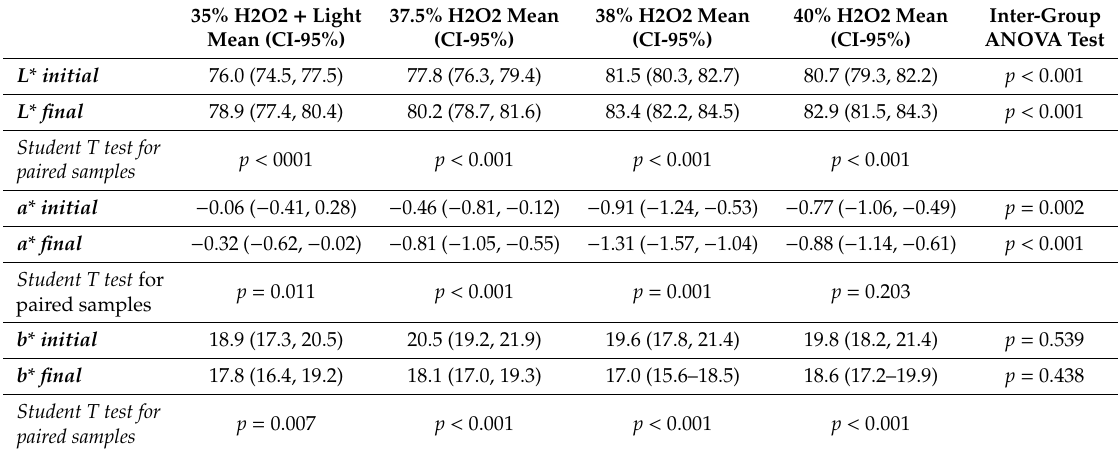
Table 1. Initial and final L*, a*, and b* values in the four study groups.